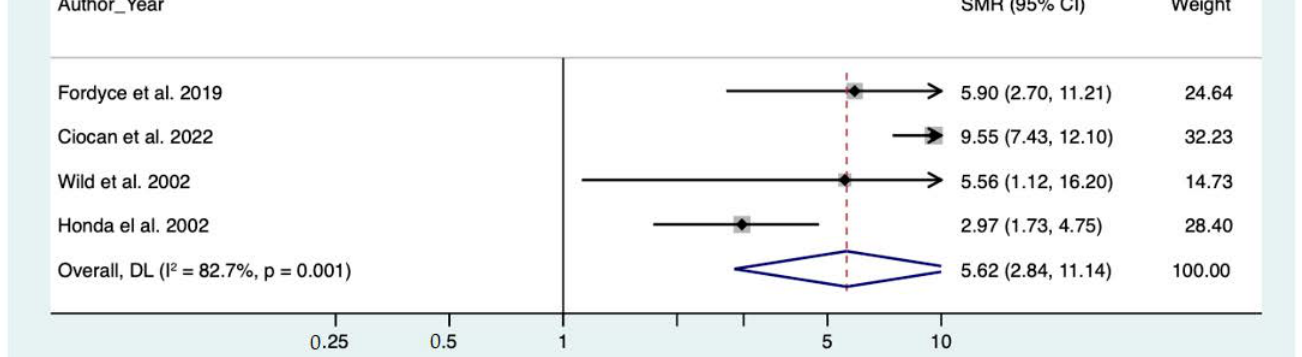
Figure 2. Meta analysis of pneumoconiosis. [7,11,12,27]